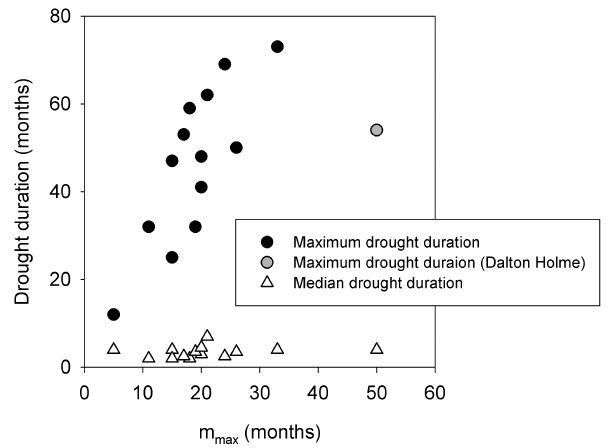
Fig. 12. Maximum and median drought durations, based on the 29yr record from 1977 to 2006, as a function of m max . The maxi- mum drought duration at Dalton Holme is an outlier and is plotted